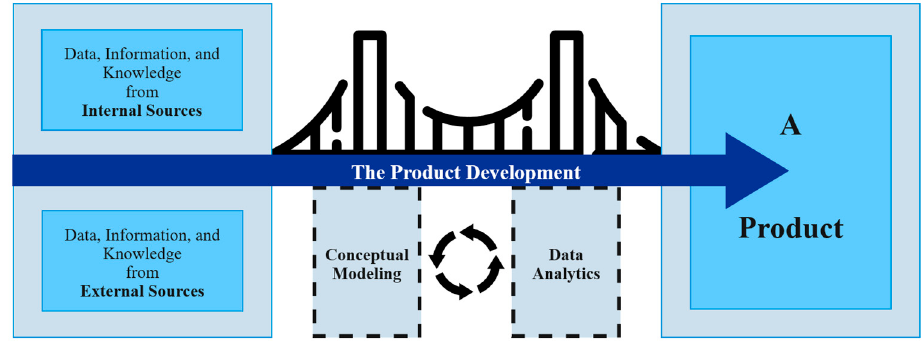
Figure 1. Bridging Data, Information, Knowledge, and Product development.